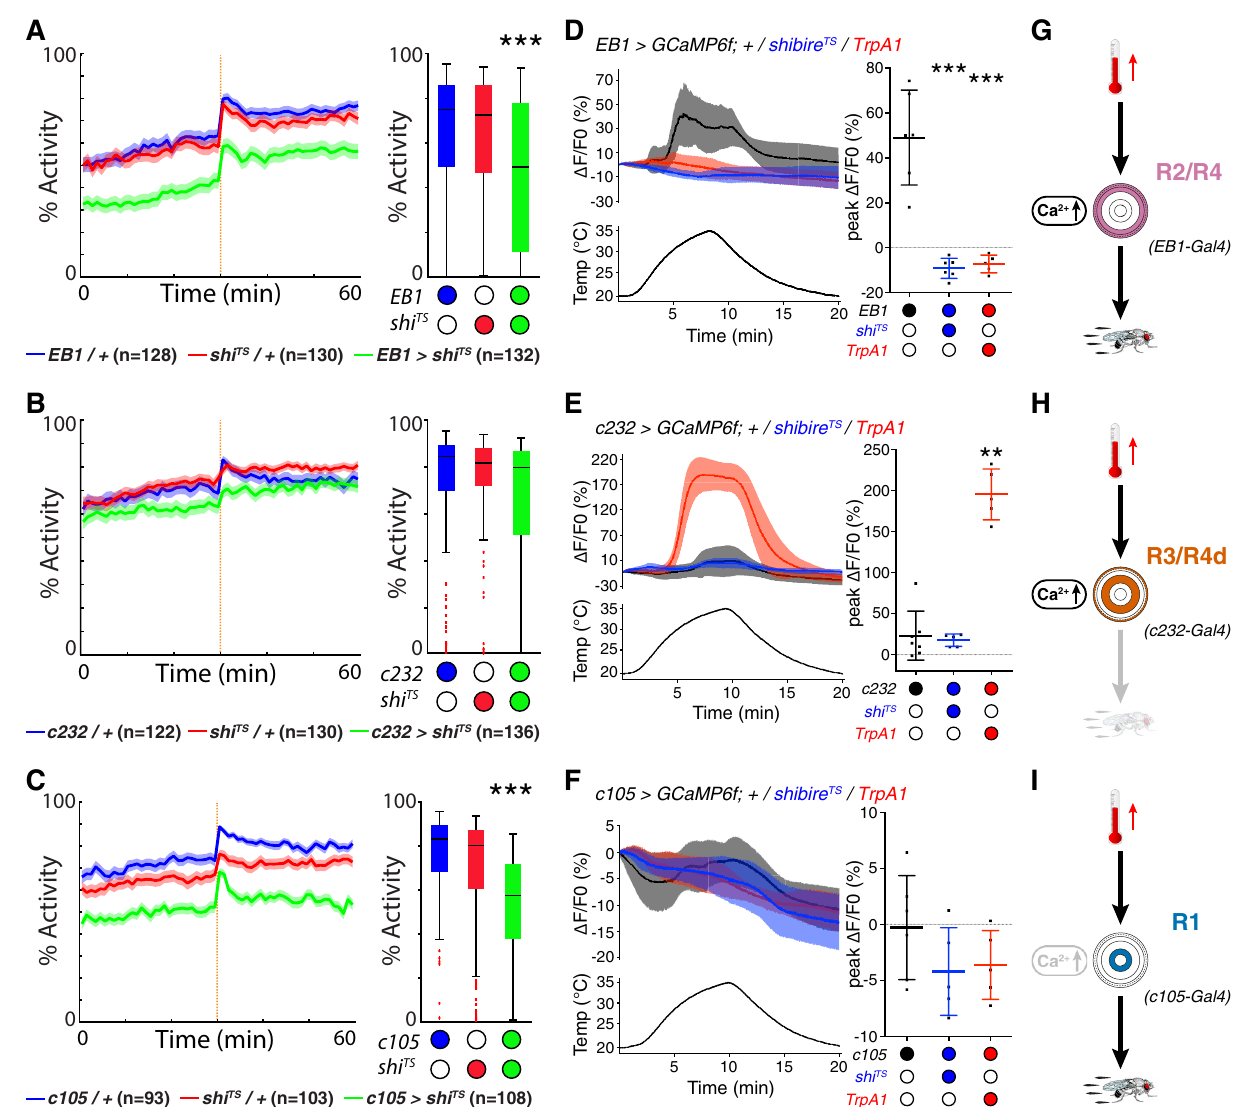
Figure 2. Segregated ring neuron activities mediate thermoresponsive motor behavior in Drosophila . ( A ) R2/R4— EB1 > shibire TS flies show reduced thermoresponsive motor behavior. Average fly locomotor activity over 60 min recordings at 31 °C; orange dashed line indicates mechanical stimulation at 30 min; shibire TS (green) compared to Gal4 (blue) and UAS controls (red). Solid line, mean; shaded area, SEM; box and whiskers, median, IQR, Tukey. ( B ) Recorded at 31 °C, activity levels of R3/R4d— c232 > shibire TS flies (green) are comparable to Gal4 (blue) and UAS (red) controls. ( C ) R1— c105 > shibire TS flies (green) show reduced thermoresponsive motor behavior, compared to Gal4 (blue) and UAS (red) controls. ( D ) Average (left) and peak (right) fluorescence GCaMP imaging of shibire TS (blue) and TrpA1 (red) R2/R4— EB1 > GCaMP6f brains to temperature ramps from 20 °C to 35 °C show no response compared to controls (black). Mean ± SD, n ≥ 5. ( E ) R3/R4d— c232 > GCaMP6f Ca 2+ signals co-expressing either shibire TS (blue) or TrpA1 (red) during temperature ramps from 20 to 35 °C reveal a massive increase with TrpA1 compared to only a small activation for controls and with shibire TS . Mean ± SD, n ≥ 5. ( F ) GCaMP imaging shows no temperature response in any condition for R1— c105 > GCaMP6f . Mean ± SD, n ≥ 5. ( G ) R2/R4 neurons integrate temperature increase and mediate thermoresponsive motor behavior. ( H ) R3/R4d neurons integrate temperature increase but do not mediate thermoresponsive motor behavior. ( I ) R1 neurons do not integrate temperature increase but mediate thermoresponsive motor behavior. **p < 0.01, ***p < 0.001, Kruskal–Wallis with Dunn’s post hoc test for ( A , C , E ), one-way ANOVA with Dunnett’s post hoc test for ( D ). See also Supplementary Figs. S1, S2 and